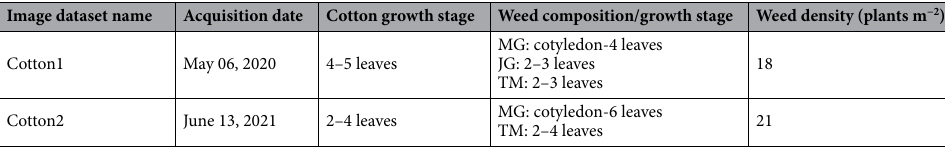
Table 1. Crop-weed conditions during real image dataset acquisition in 2020 and 2021 using a Fujifilm camera. MG morningglories, JG johnsongrass, TM Texas millet.